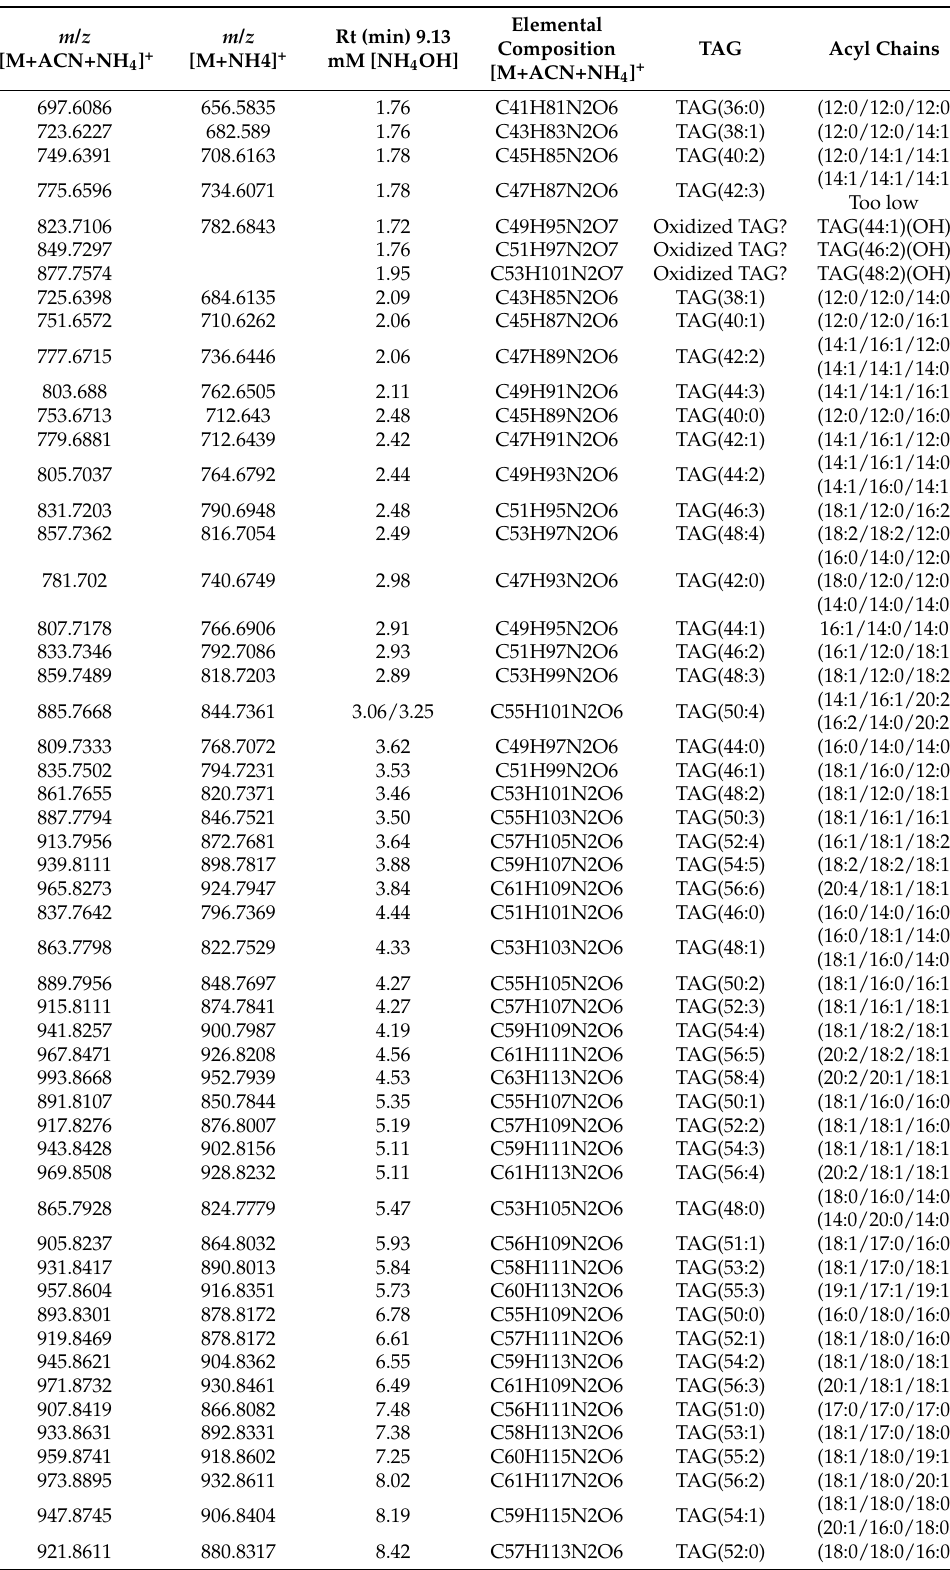
Table 2. Triacylglycerols (TAG) identified in an ovine plasma sample. More than one structure is proposed where no resolution was feasible. The regioisomery was established according to the rules found for the standard compounds. Rt means retention